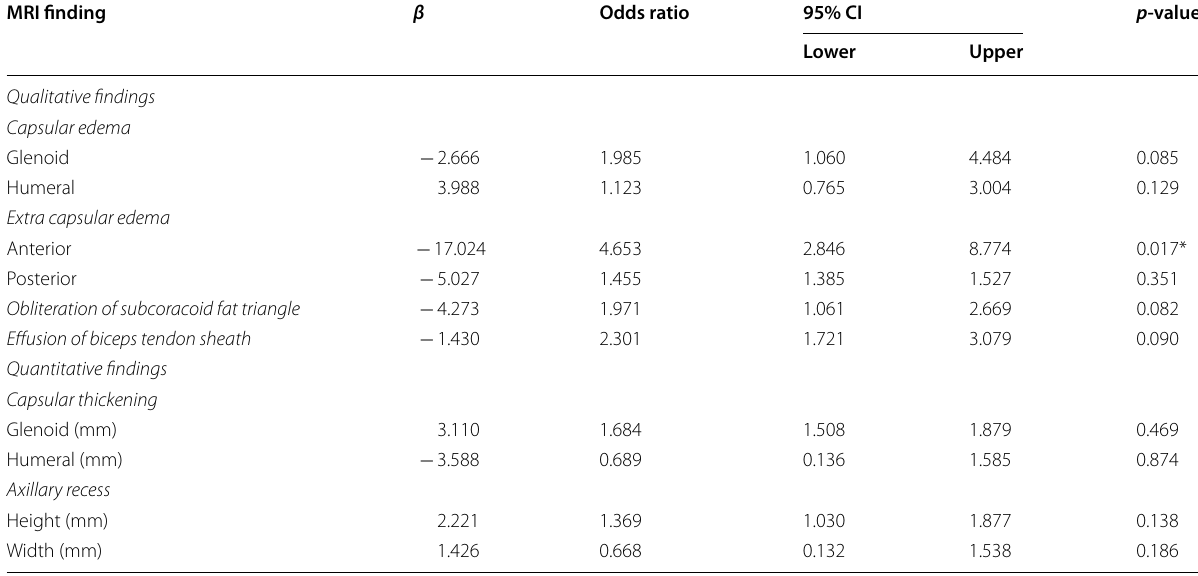
Table 10 Results of linear regression analysis to estimate variables which are most predictive of clinical impairment at limitation of ROM “abduction”